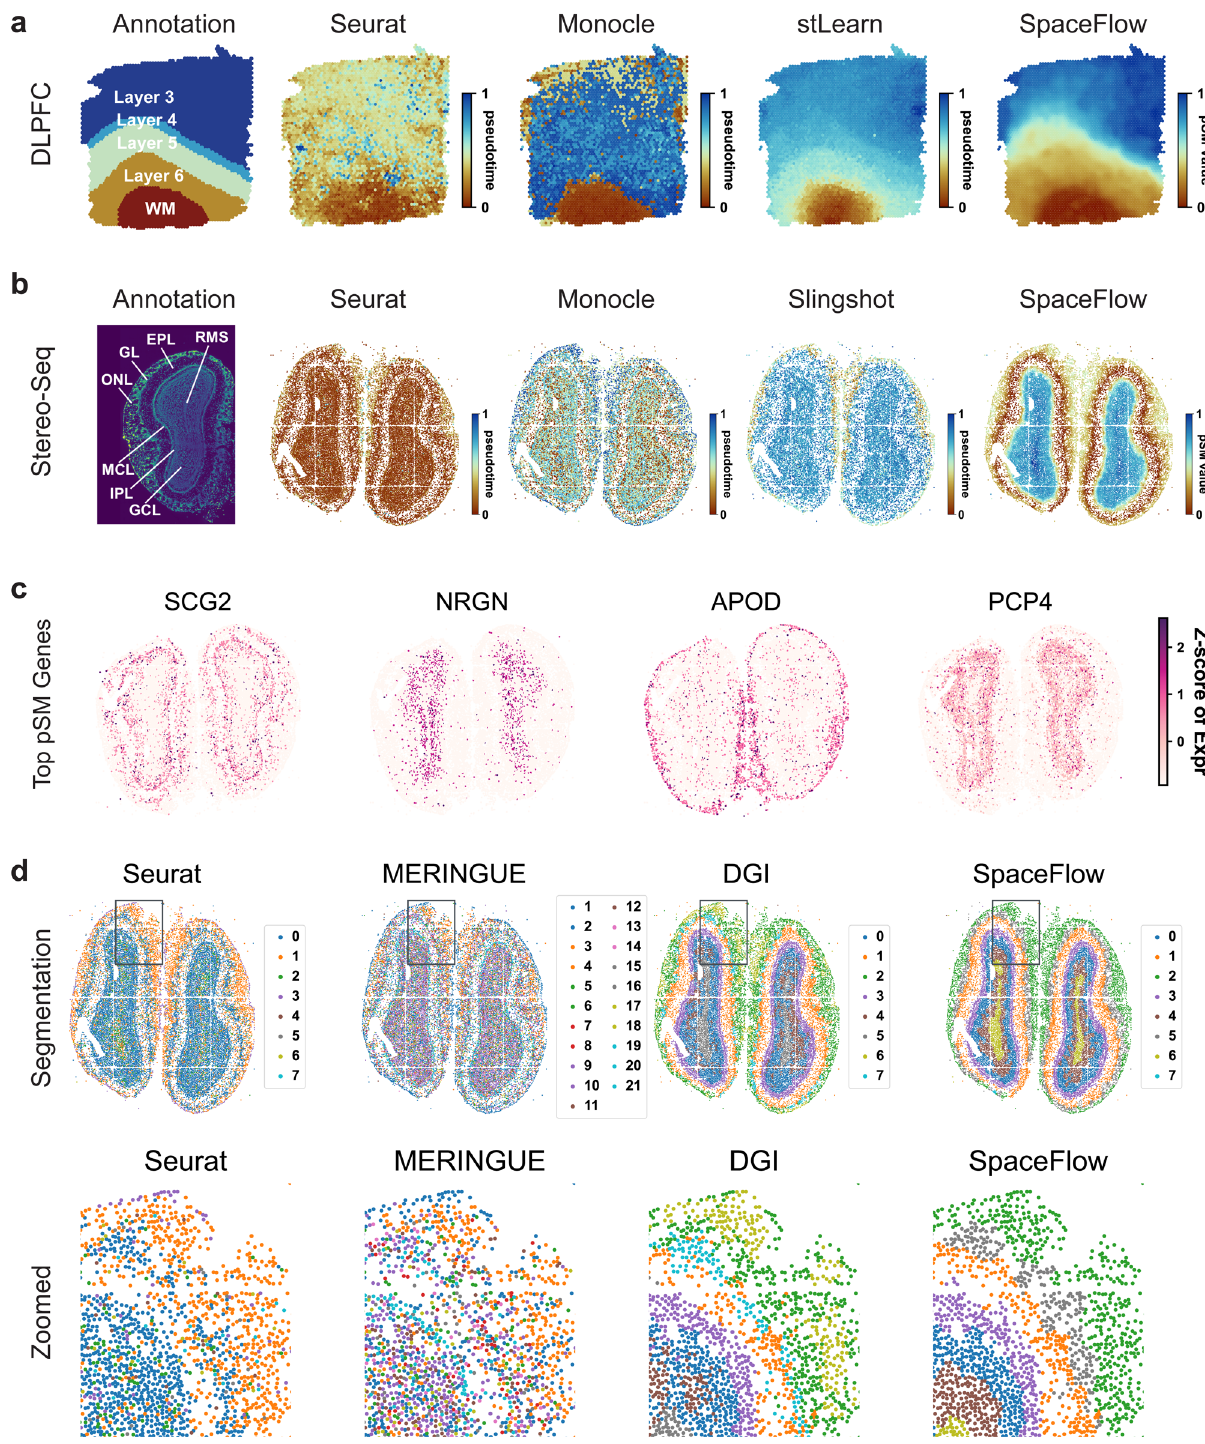
Fig. 3 SpaceFlow generates pseudo-Spatiotemporal Map for ST data and uncovers pseudo-spatiotemporal relationship between cells in both spots- resolution and single-cell resolution ST data. a Spatial visualization of pseudotime calculated by Seurat, Monocle, stLearn, and the pSM generated by SpaceFlow on DLPFC data (same dataset as in Fig. 2, spot resolution). b Spatial visualization of pseudotime calculated by Seurat, Monocle, Slingshot, and the pSM generated by SpaceFlow on Stereo-seq data (single-cell resolution). c Spatial expression of genes exhibiting the highest correlation between expression and the pSM value of corresponding spots/cells. The color represents the z-score of expression level. d Domain segmentations of Stereo-seq ST data given by Seurat, MERINGUE, DGI, and SpaceFlow. Top row: full views of the domain segmentations from different methods, bottom row: zoomed views of regions boxed in each